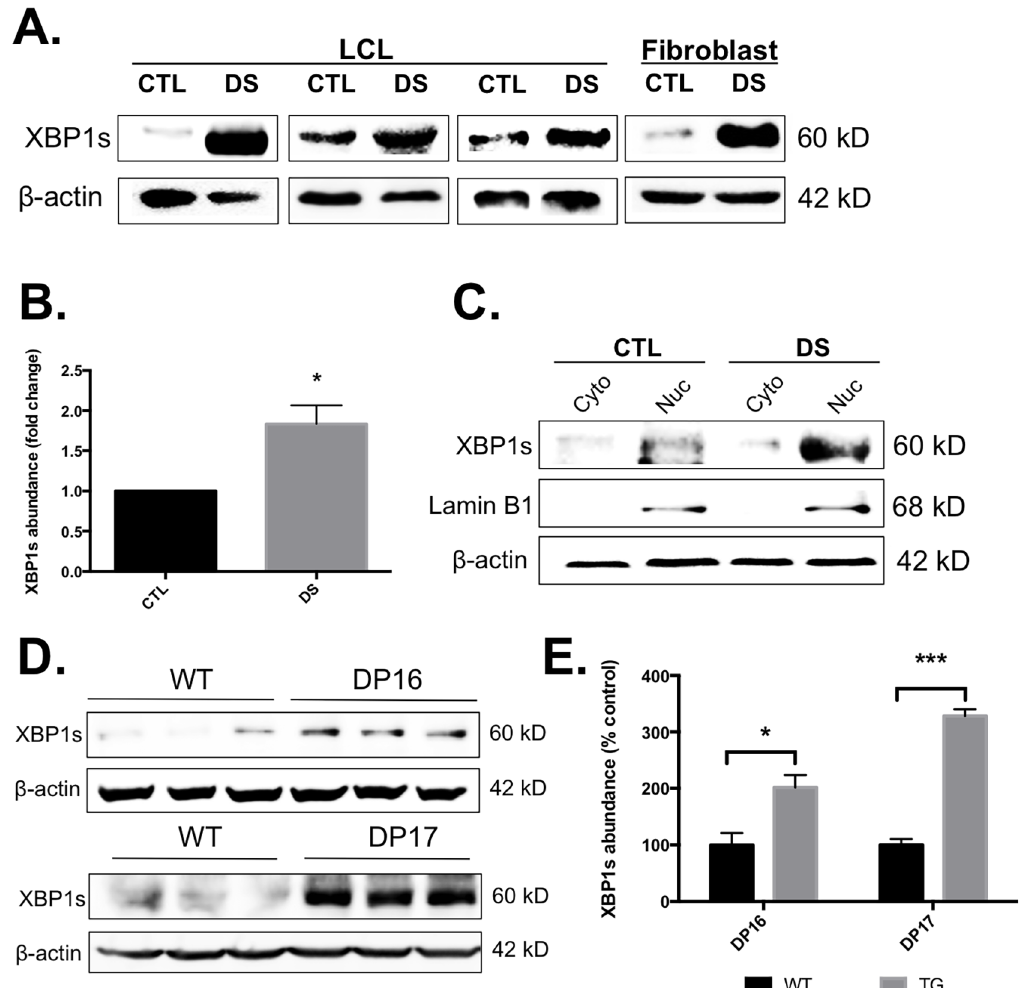
Fig 4. LCLs and fibroblasts from DS patients and mouse models of DS display increased abundance of XBP1s and XBP1s was found localized to the nucleus. Unstimulated LCLs and fibroblasts from DS individuals and age-matched controls were examinedfor XBP1s abundance using Western blot (A-C). Both DP16 and DP17 (D) mice displaysignificantincreasein XBP1s abundancein the brain (E). Western blots were conductedin triplicate and the images are representative of these replications. WT, wild type; TG, transgenic (DP16 or DP17); n = 3, * P <